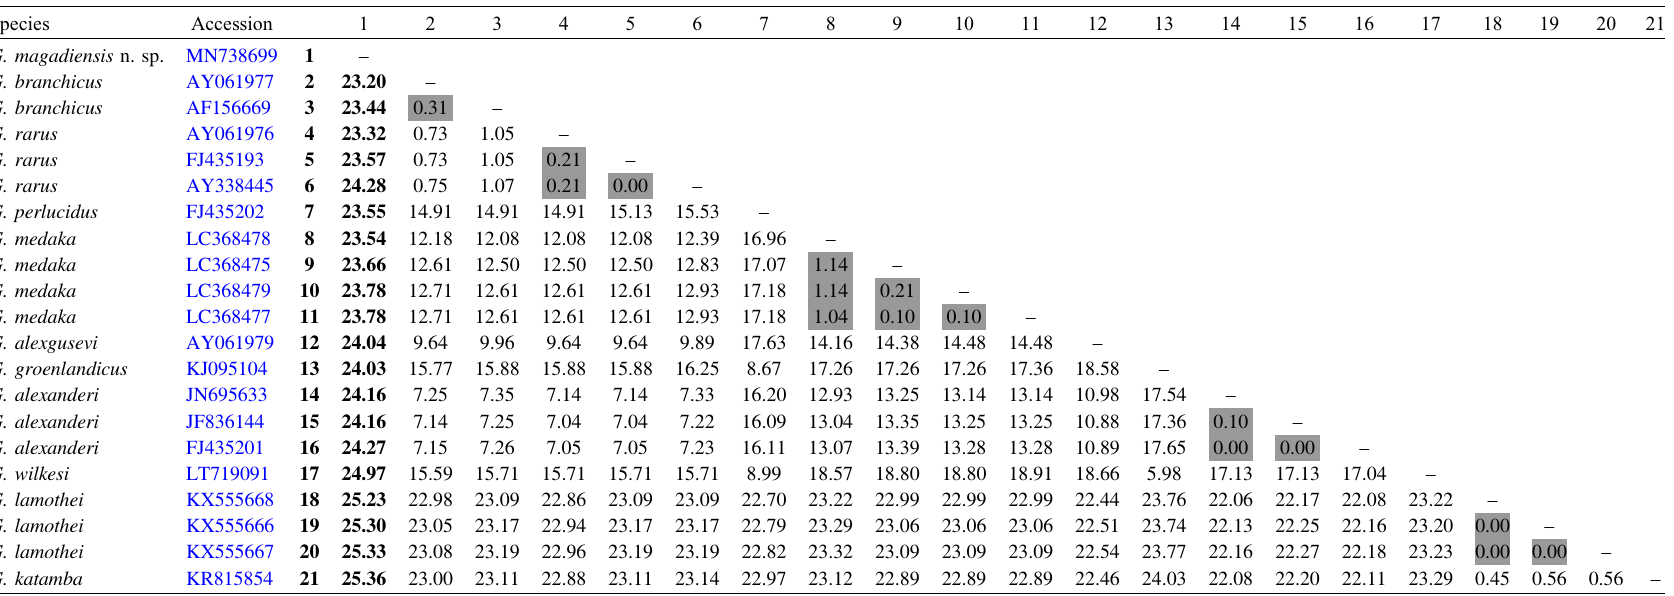
Table 4. Sequence divergence (%) based on average uncorrected p -distance separating Gyrodactylus magadiensis n. sp. (values in bold) from other Gyrodactylus species. Intraspeci fi c distances indicated by shaded